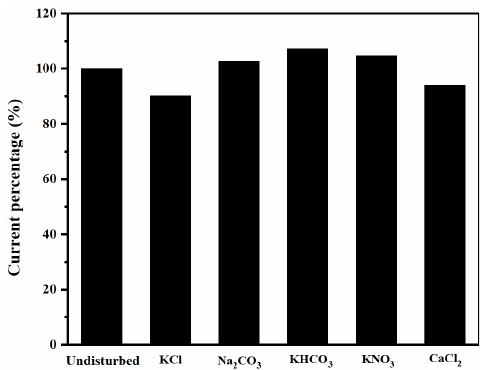
Figure 13. Influence of different interfering ions on response current.